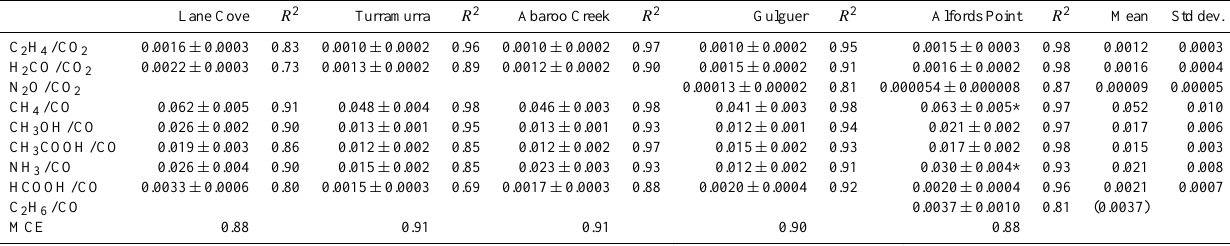
Table 3. Results of the generalised least squares regression analysis, with the emission ratio (ER) and its uncertainty ( S ER ) . Also shown is R 2 , the square of the correlation coefficient to a simple linear regression. The arithmetic mean and standard deviation of the emission ratios measured at all of the fires are given. In addition the modified combustion efficiency (MCE) values calculated via the summation method for each fire are